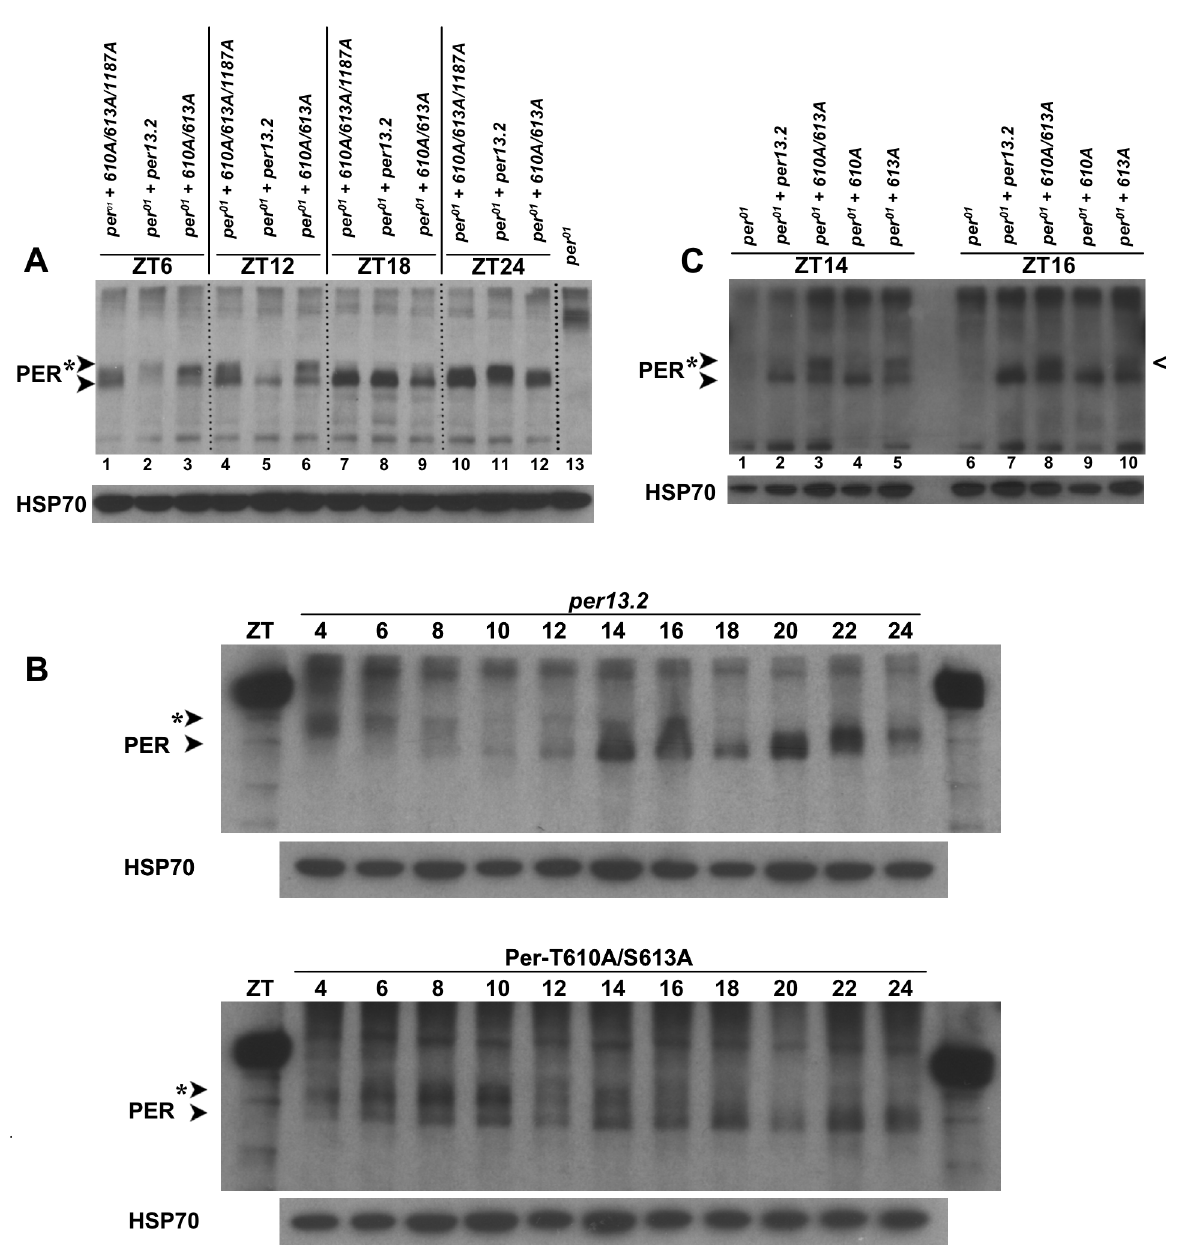
Figure 5. PER-T610A/S613A exhibits defects in protein phosphorylation and stability. ( A ) Head extracts were prepared from an equal number of per 01 flies expressing a wild type per 13.2, PER-T610A/S613/S1187A, or PER-T610A/S613A transgene at the indicated time points. At ZT6, wild type PER (lane 2) is hyperphosphorylated and is declining in levels while both mutant forms of PER are hypo-to-moderately phosphorylated and appear stabilized (lanes 1 and 3). At ZT12, strictly hypophosphorylated wild type PER, presumably representing a new round of synthesis, is observed (lane 5) while mutant PER remains hypo-to-moderately phosphorylated and stable. By ZT18, mutant PER also appears in a hypophosphorylated form, though a small smear in mutant lanes is consistently observed. At ZT24, wild type PER (lane 11) is already becoming moderately phosphorylated while the mutant forms remain hypophosphorylated. As a control, per 01 flies without a transgene are shown in lane 13. Similar results were obtained for at least three independent experiments. ( B ) A time course comparison between wild type PER ( per 13.2) and PER-T610A/S613A. Head extracts were prepared from an equal number of flies every two hours at the indicated time points. When levels of wild type PER levels are lowest (top blot, ZT8-12), PER-T610A/S613A levels remain high; lowest level of PER-T610A/S613A expression is most consistently seen between ZT16-20. Note the smear at ZT14 and ZT16 in the per 13.2 blot is not representative of phosphorylation but rather an artifact in those lanes. ( C ) The single PER-T613A mutant becomes hypophosphorylated earlier in the day than does the PER-T610A/S613A double mutant. Notice at ZT16, the single mutant (last lane) is almost completely hypophosphorylated (caret) while the double mutant remains moderately phosphorylated at this time point. Similar results were obtained from two different experiments.